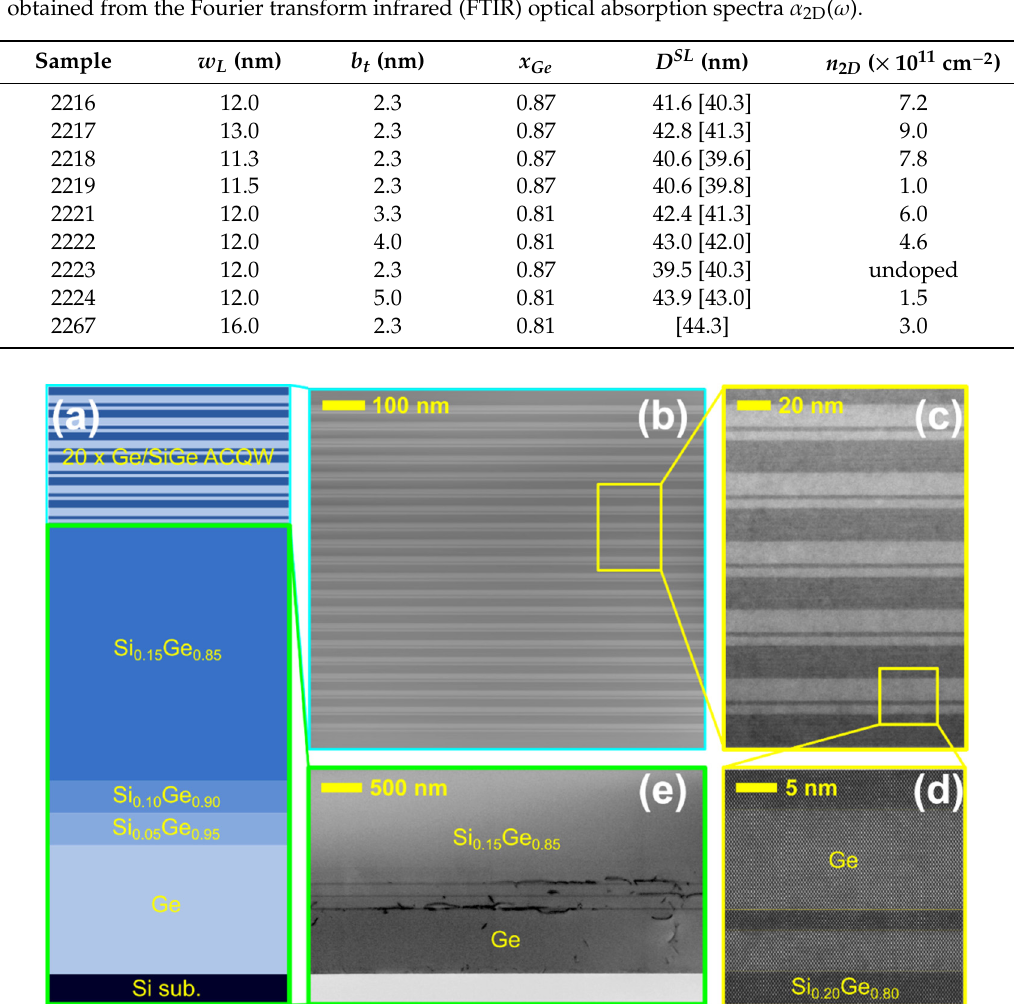
Figure 1. ( a ) Schematics of the structure of the grown heterolayers from the virtual substrate (VS) to the active region on top. ( b − e ) Scanning transmission electron microscopy (STEM) micrographs of a typical ACQW sample: panels ( b ) − ( d ) show increasing magnifications of the active region composed by the alternation of Ge wells and SiGe barriers at different compositions, as described in the text. Panel ( e ) reports the part of the VS underlying the active region being close to the Si substrate, including the Ge buffer and the reverse-step graded (RG) SiGe step layers.